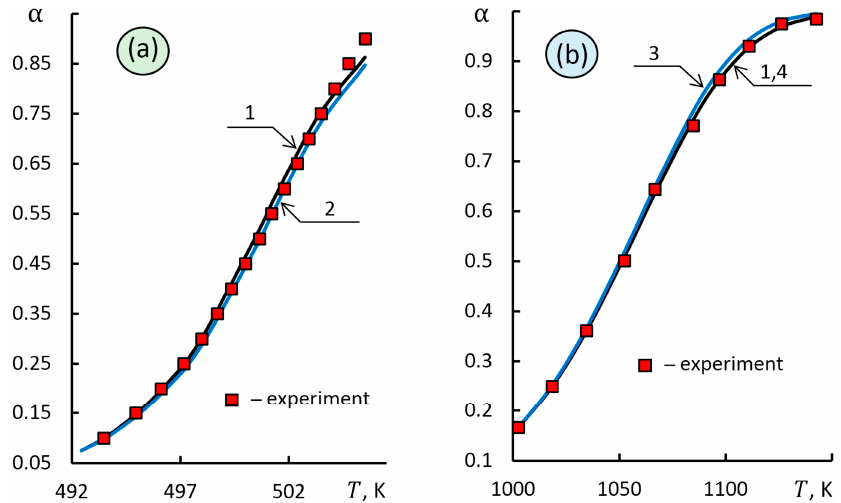
Figure 5. Results of solving the direct problem for kinetic triplets identified using various integral methods: (a) 1—proposed approach, 2—estimation [6]; (b) 1—proposed approach, 3—combined kinetic analysis [12,37], 4—Coats-Redfern method [5]. Table 4. Percentage accuracy of various kinetic triplets for the model Equation (5).